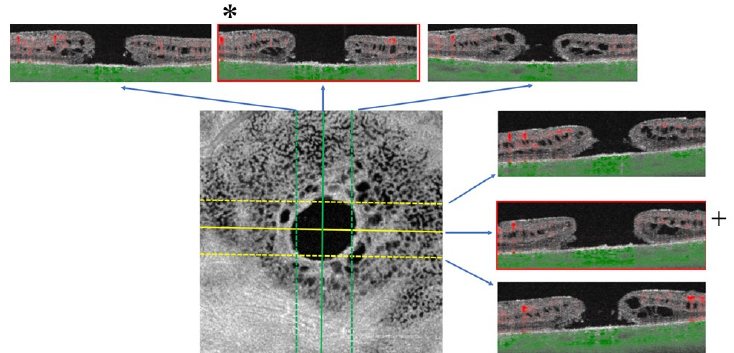
Figure 2. Identifying the center of the macular hole in an en face image manually. Examiner checked all horizontal and vertical scan image, and detected longest hole diameter images (horizontal; +, vertical; *). The center of macular hole is the intersection of the slices of the area with the largest diameter in the horizontal and vertical B-scan images of the OCT. The center point was output to en face image.